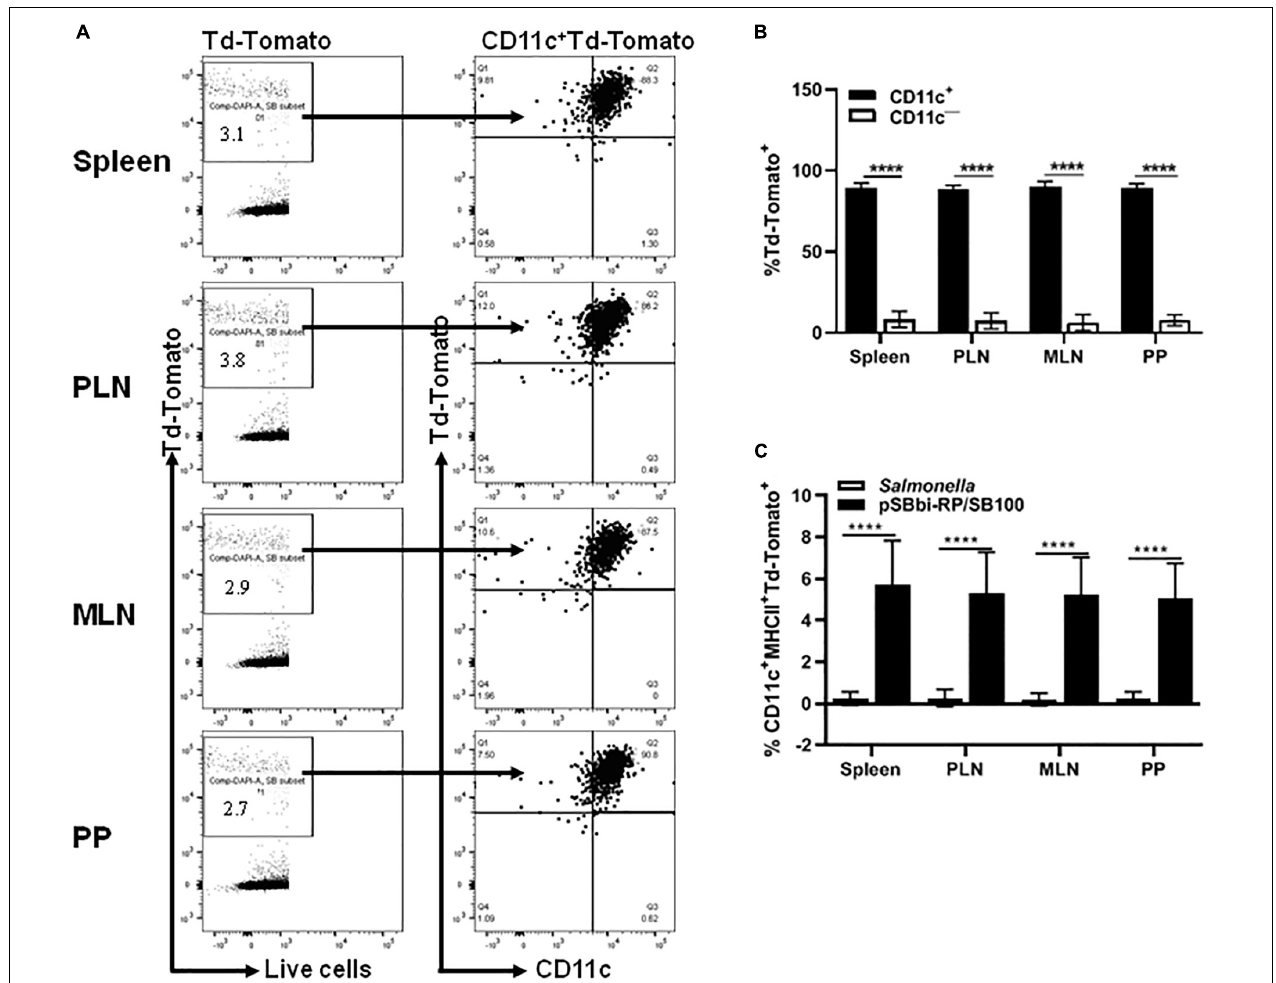
FIGURE 2 | In vivo detection of the red fluorescent protein in different organs of vaccinated NOD mice. NOD mice were given a single oral dose of Salmonella -containing plasmid (pSBbi-RP/SB100, n = 10) compared to Salmonella only ( n = 10). Four weeks post-vaccination, red fluorescent protein was detected in different organs. (A) Representative FACS plots gated the frequency of live red-labeled CD11c + and CD11c − cells in the spleens, pancreatic lymph nodes (PLN), mesenteric lymph nodes (MLN), and Peyer’s patches (PP) of mice from each group. (B) Quantification of the percentages of the CD11c + and CD11c − red-labeled cells in all organs. (C) Quantification of the percentages of red-labeled CD11c + MHCII + in total live cells isolated from the spleen, PLN, MLN, and PP. The data shown are as the average with standard deviation (SD) obtained from two independent experiments. Statistical analysis using two-way ANOVA shows significance between groups (**** p <